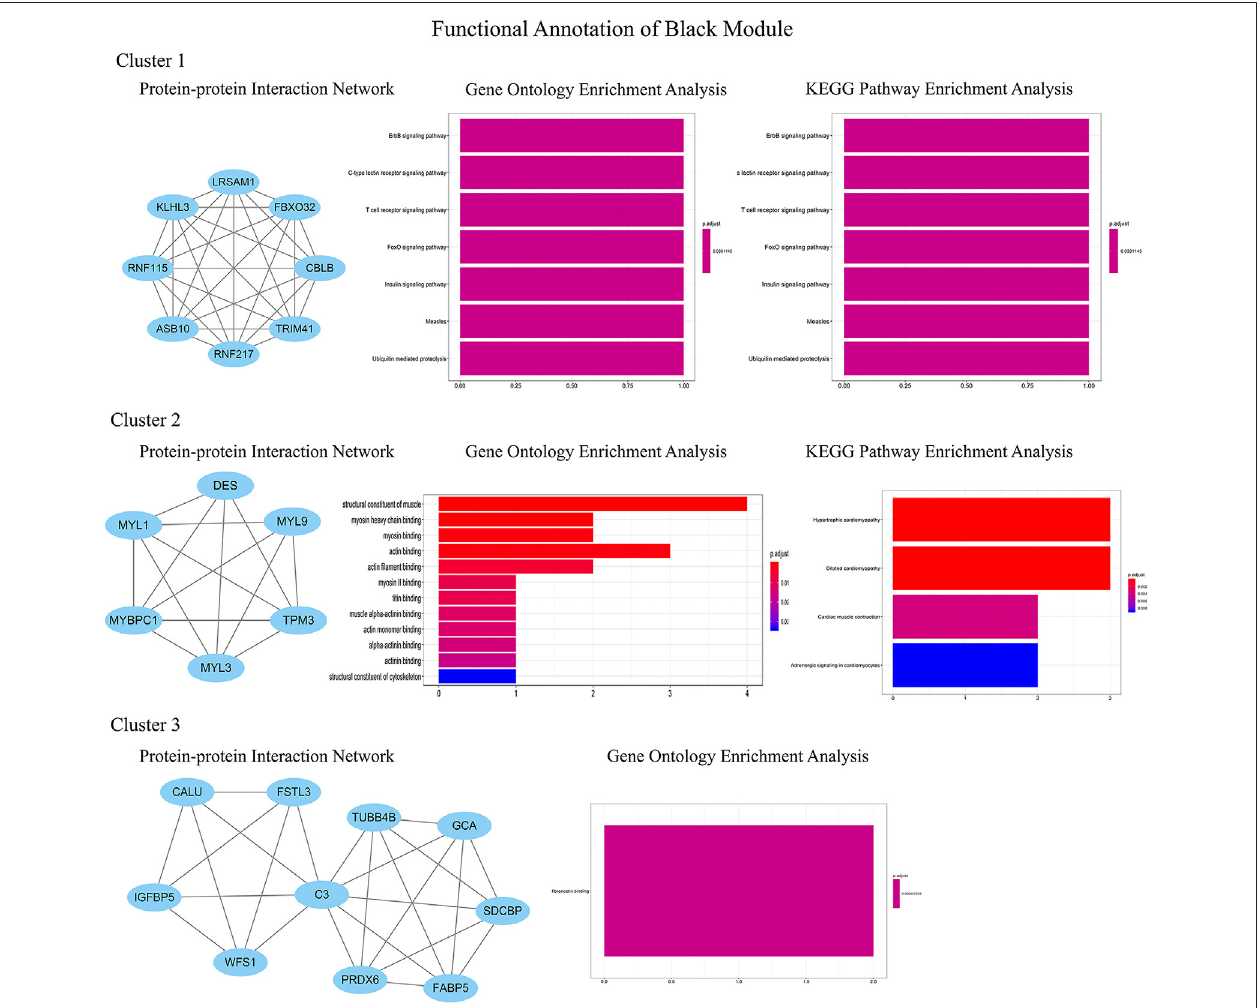
FIGURE 4 | Functional annotations of three clusters in black module (including protein-protein interaction network, gene ontology enrichment analysis and KEGG pathway enrichmentanalysis).GOfunctionalanalysisshowedthatthegenesinblackmodulecontributedtomusclecomposition,myosin,actin,and fi bronectinbinding, while KEGG analysis demonstrated that the genes were enriched in diastolic and contractile signaling pathways of cardiomyocytes.